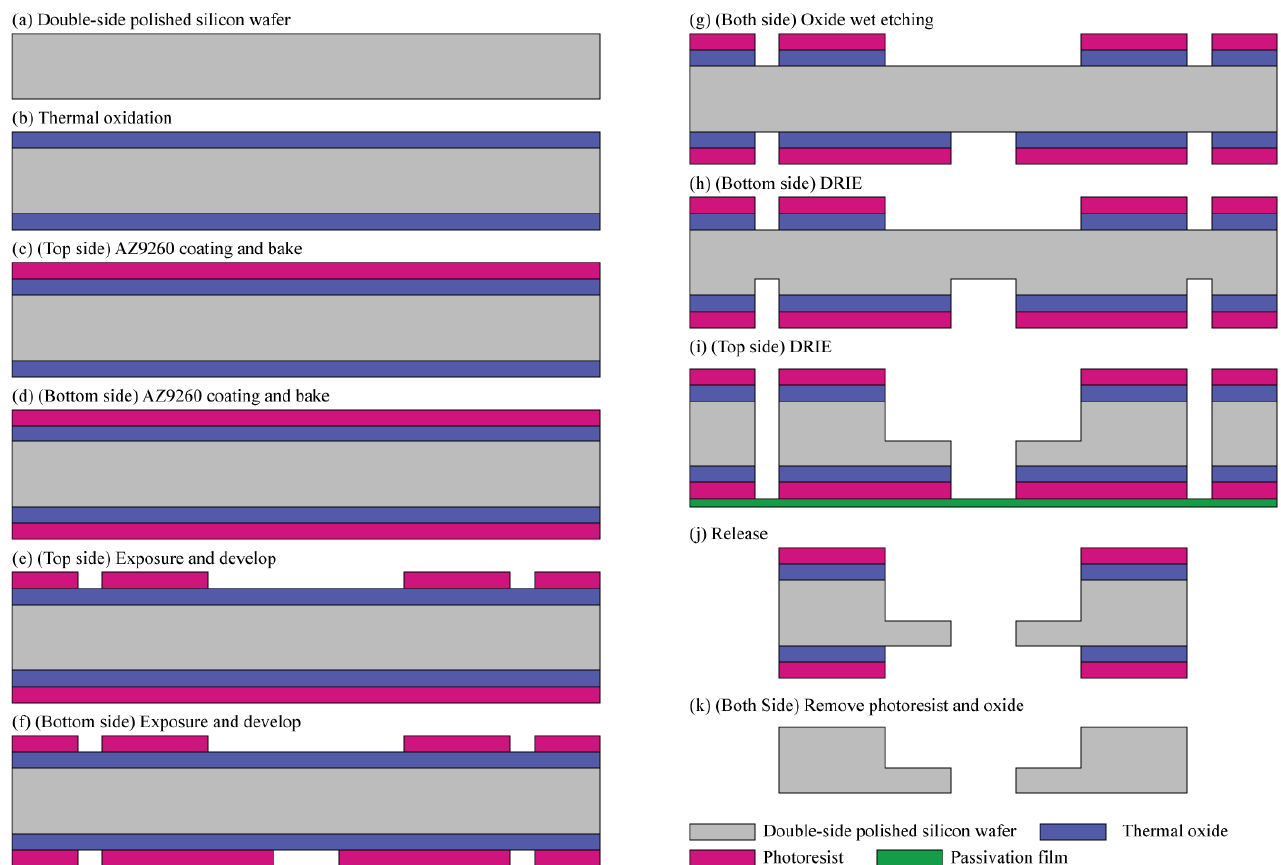
Figure 2. Fabrication process flow of the proposed MEMS turbine rotor.